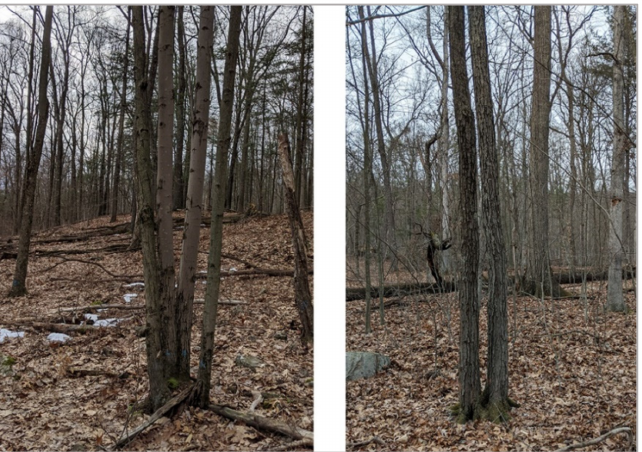
Figure 12. A multi-stem tree ( left ), which was recorded as four separate trees in the tree survey but identified as one tree using our method, and a double stem ( right ) recorded as two trees in the survey but detected as one tree by our